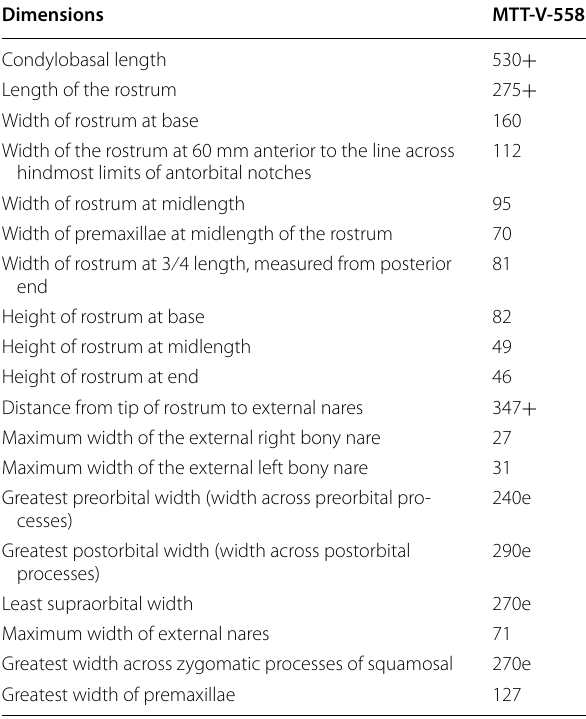
Table 1 Measurements (in mm) of the referred skull of the Caujarao delphinidan MTT-V-558 (modified